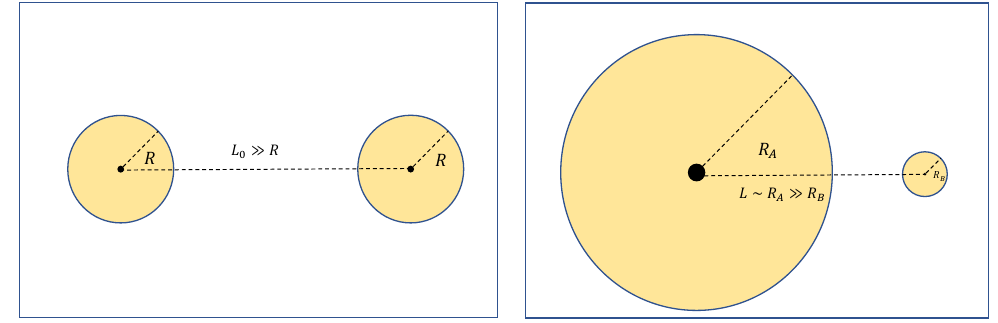
Figure 1 . Two conformally equivalent configurations for the mutual information. The left: two spherical subregions of radius R separated by a distance L of radius R and R separated with distance L ∼ R A B